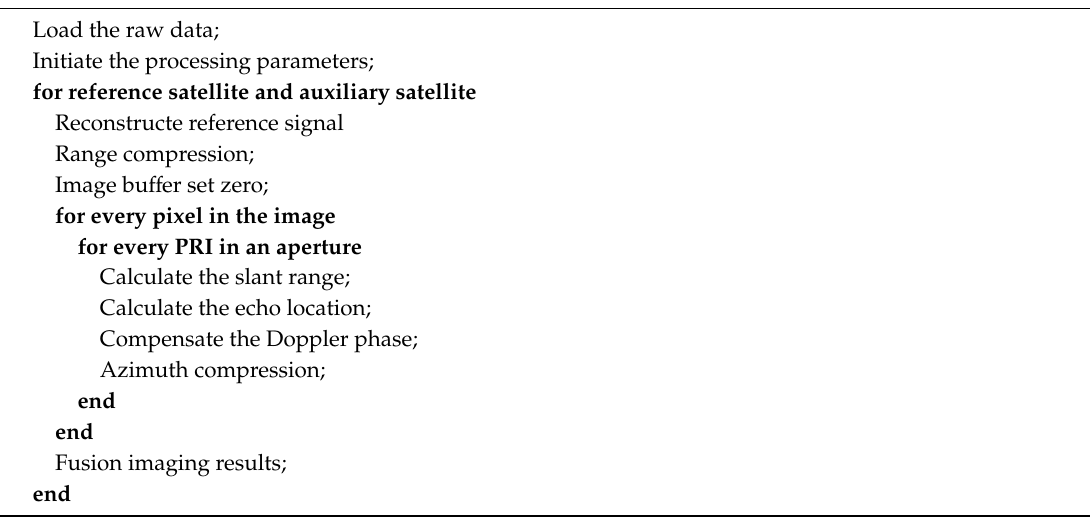
Algorithm 2: Fusion Imaging Algorithm